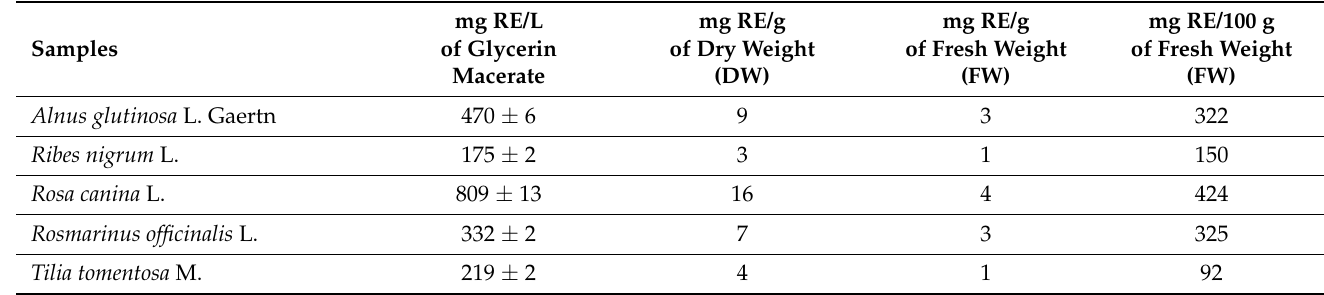
Table 3. Total flavonoid content (glycosylated and aglycones in rutin equivalent